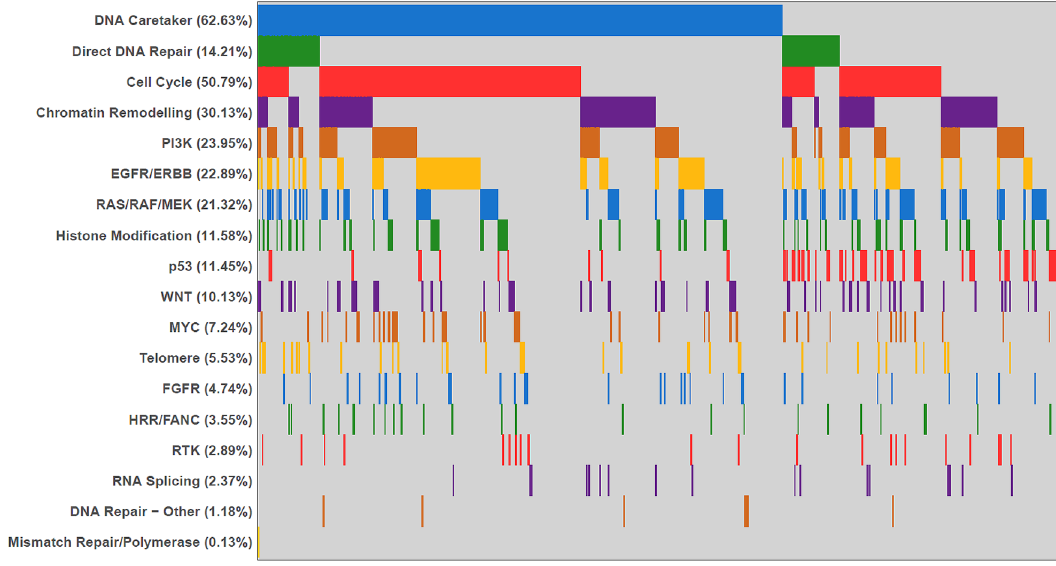
Figure 2. Most common altered genomic pathways in 760 patients with gallbladder cancer.